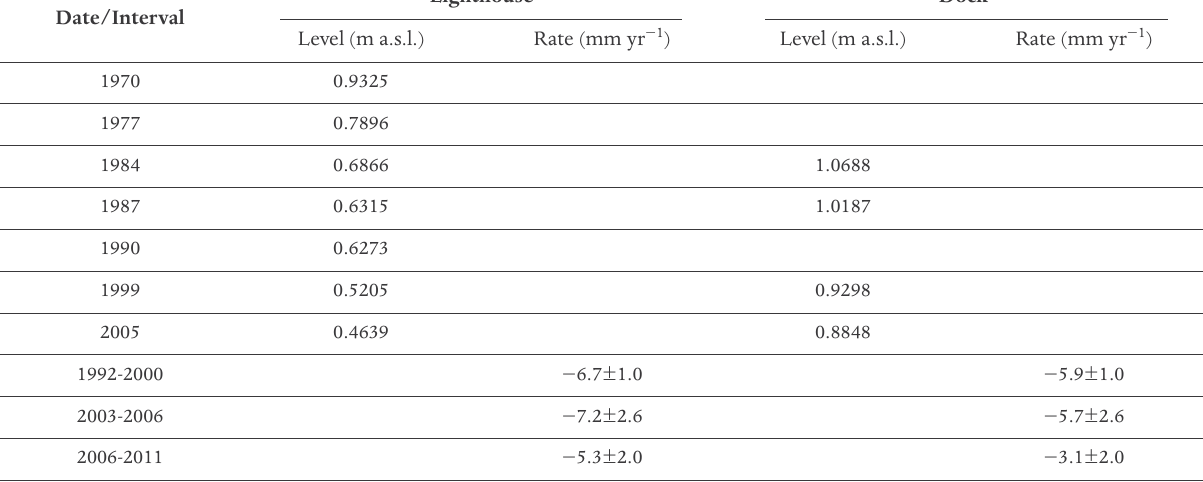
Table 2. Direct and undirect height measurements at the lighthouse and at the dock of Marina di Ravenna from the subsidence surveys pre- sented in Table 1. A distinction is made between data sampled as height a.s.l. (e.g. levelling data, column “Level”) and as average rates dur- ing specific time intervals (e.g. InSAR, column